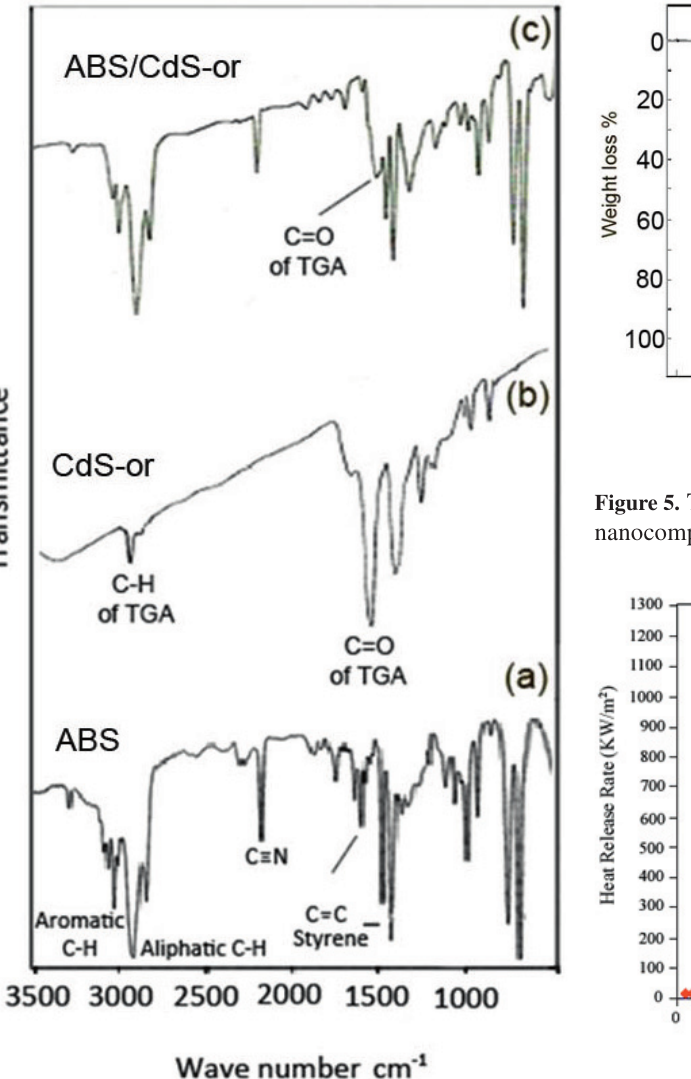
Figure 6. Heat release rate (HRR) for pure ABS and (b) ABS/CdS-or